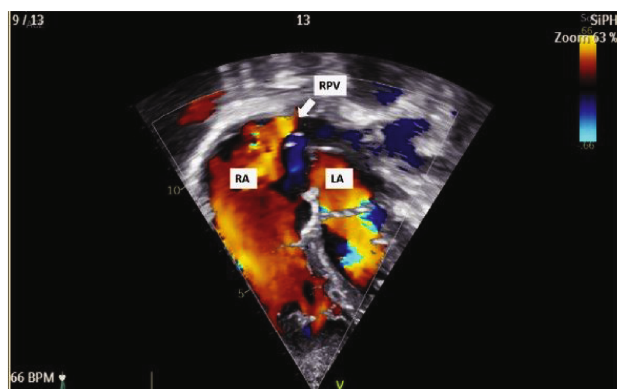
Figure 2: Echocardiography showing a four-chamber view with partial anomalous right pulmonary venous drainage with blood fl ow from the right lower pulmonary vein to inferior vena cava. LA: left atrium; RA: right atrium; RPV: right pulmonary